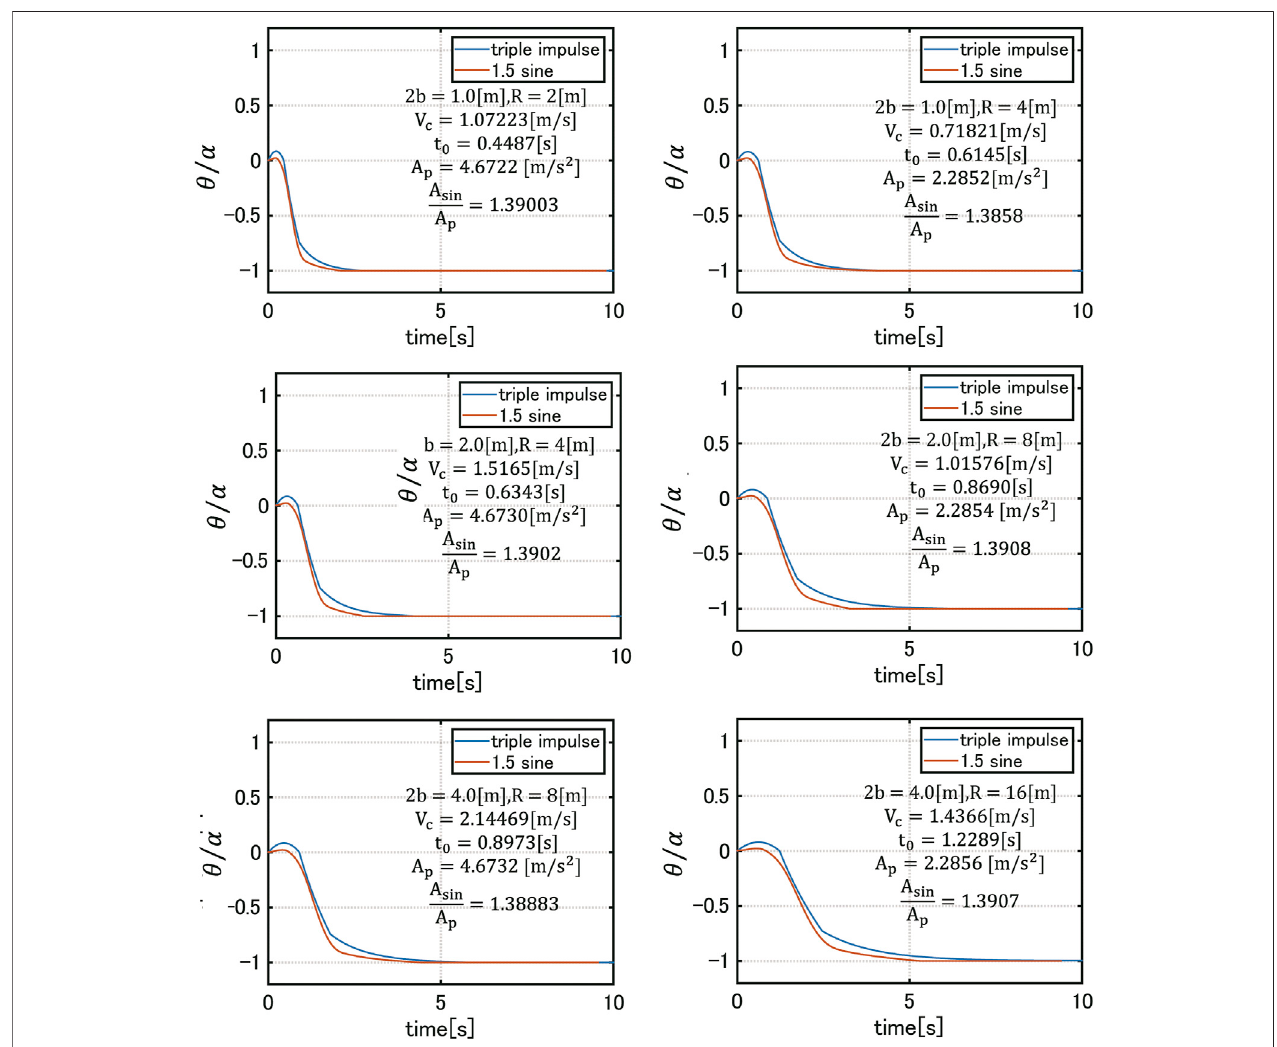
FIGURE 10 | Comparison of time-history responses θ ( t )/ α at overturning limit between the triple impulse and the corresponding equivalent 1.5-cycle sinusoidal wave magni fi ed by a coef fi cient about 1.38 – 1.39.